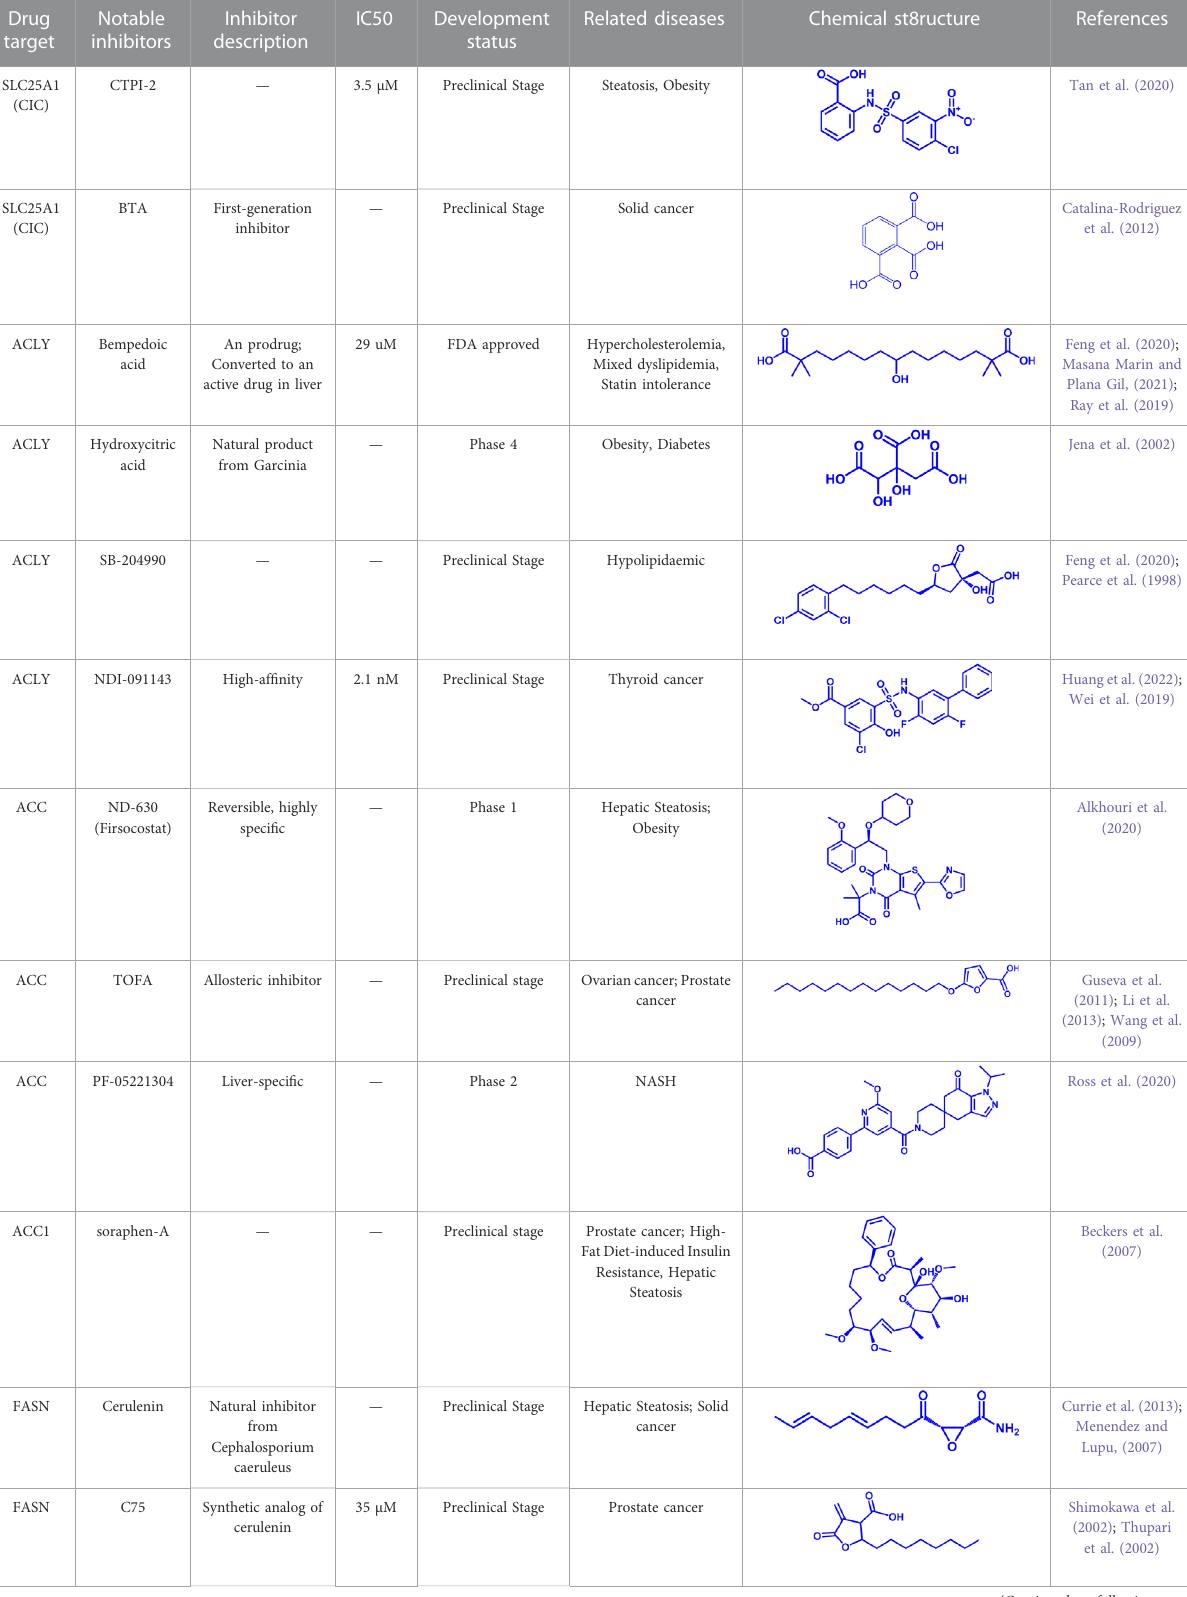
TABLE 2 Potential pharmacological targets and related inhibitors targeting fatty acid